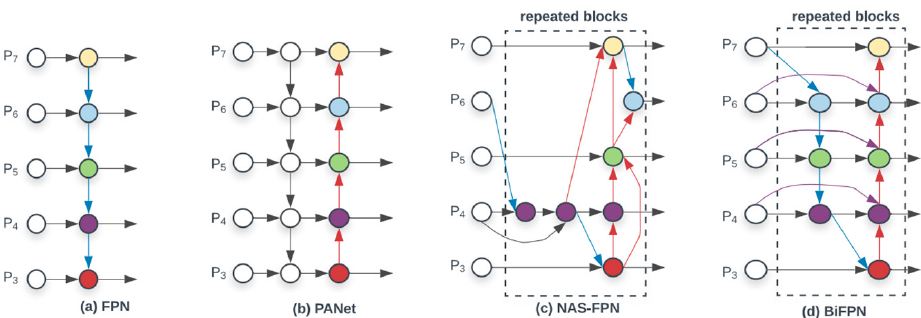
Figure 5. Common architecture used in YOLO neck modules.